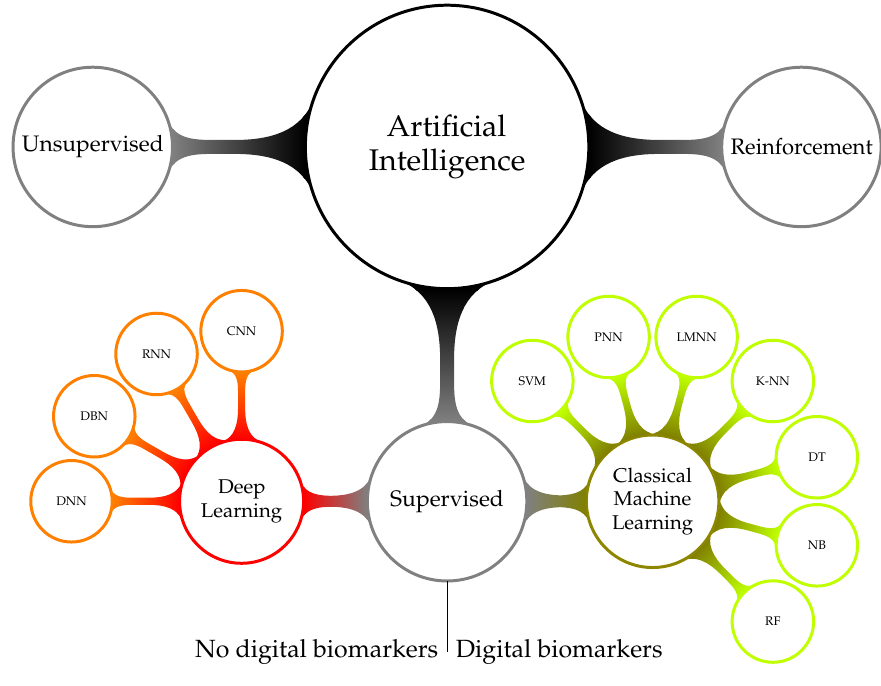
Figure 5. Taxonomy of artificial